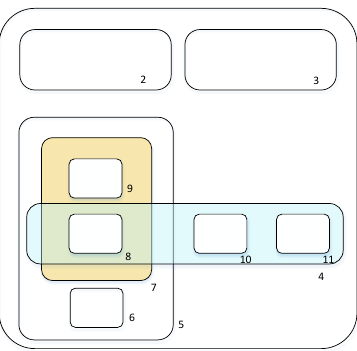
Figure 4. Chain membrane structure.